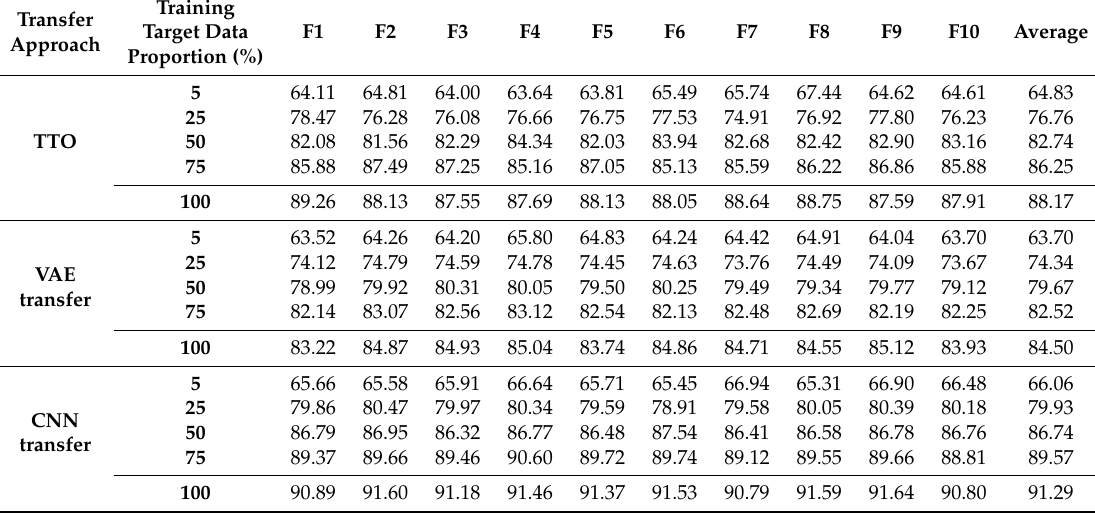
Table 10. 10-fold cross validation accuracies (in %) of TTO, VAE-transfer, and CNN-transfer after downsampling of the training set for the classification of AROUSAL on the DEAP dataset. F i refers to fold number i